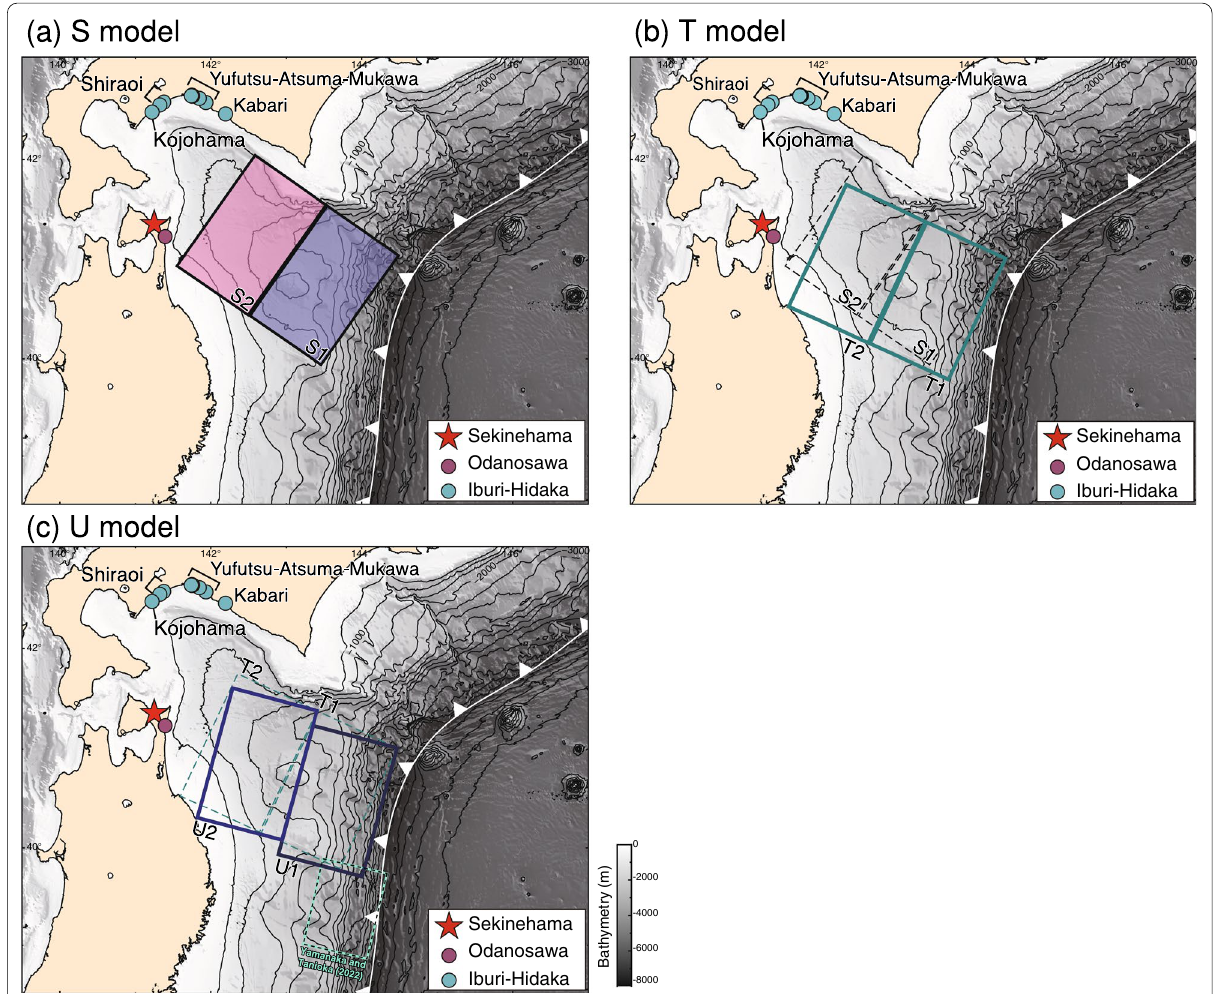
Fig. 4 The six new models at the flexure of the Kuril and Japan Trenches. Alphabetized 1 and 2 mean the difference in fault locations: shallow and deep parts of the plate interface, respectively. a S, b T, and c U models are set by changing the fault strikes. For the details of these parameters, see Table 4. The red star, pink, and light blue circles show the tsunami deposit locations reported by previous studies used in this study. The black lines are bathymetric contour lines drawn at 500 m intervals. The plate boundary was adapted from Iwasaki et al.